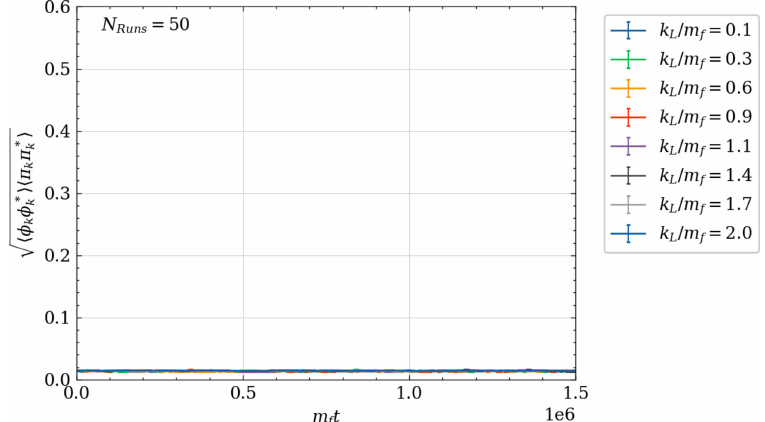
Figure 12 . The evolution of the occupation numbers in 1+1 dimensions, (cid:15) = 0 . 5 , φ 0 = 1 . 5 , am f = 0 . 06 .